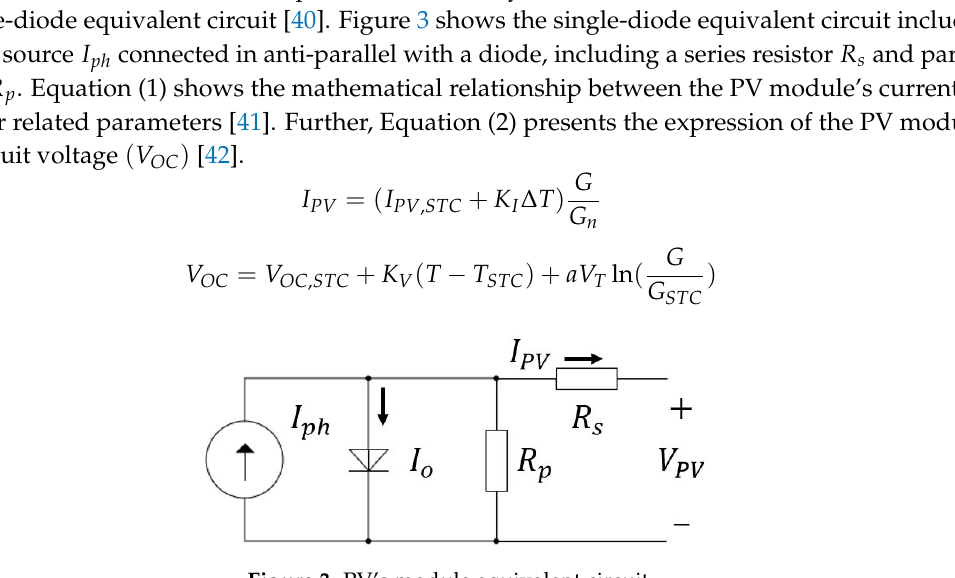
Figure 3. PV’s module equivalent